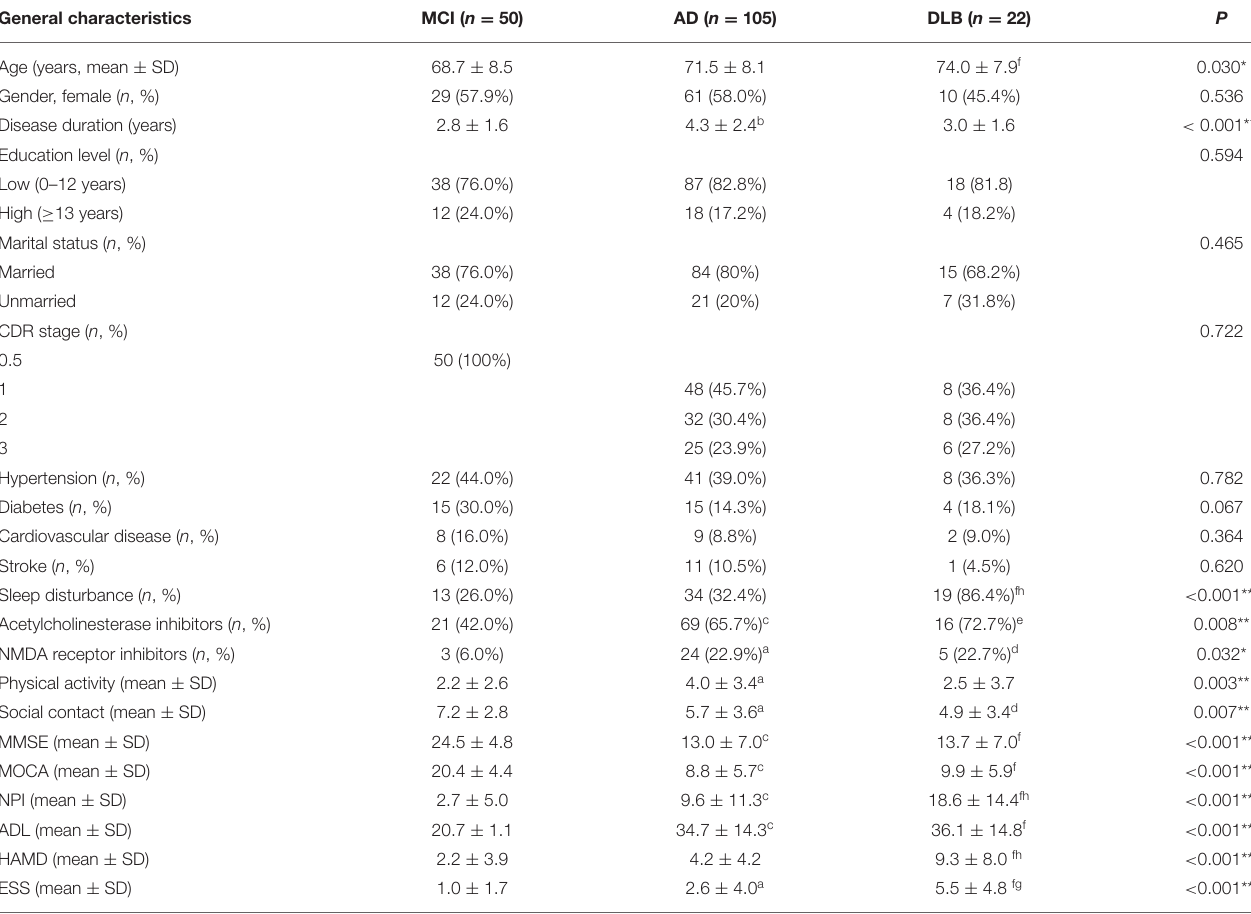
TABLE 1 | Baseline characteristics of patients with mild cognitive impairment (MCI), Alzheimer’s disease (AD) and probable dementia with Lewy bodies (DLB). General